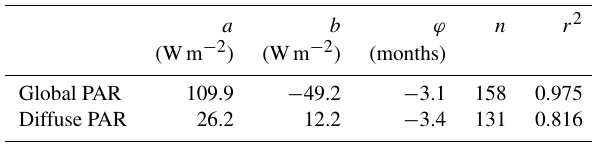
Table 4. Coefficients of the fit, number of data and correlation co- efficient for the cloud-free global and diffuse monthly PAR time